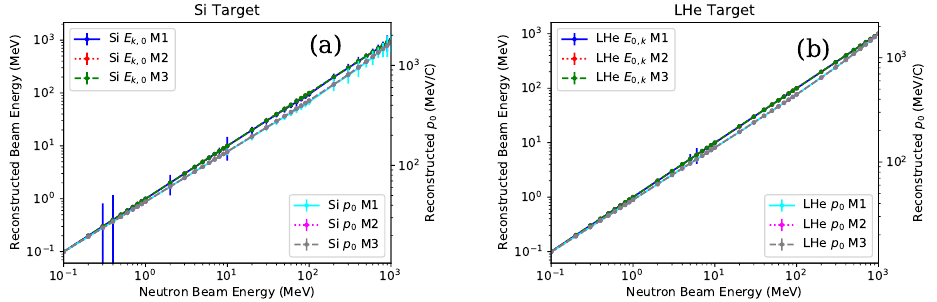
Figure 12. The reconstructed initial momentum p 0 (green solid and magenta dotted lines) and beam energy E k ,0 (blue solid and red dotted lines) of neutrons for M1 (solid) and M2 (dotted). ( a ) Silicon target. ( b ) Liquid helium